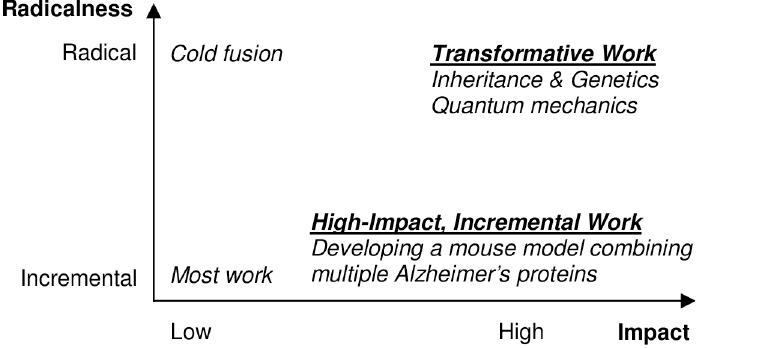
Fig 1. Classification of scientific work by radicalness and impact, with